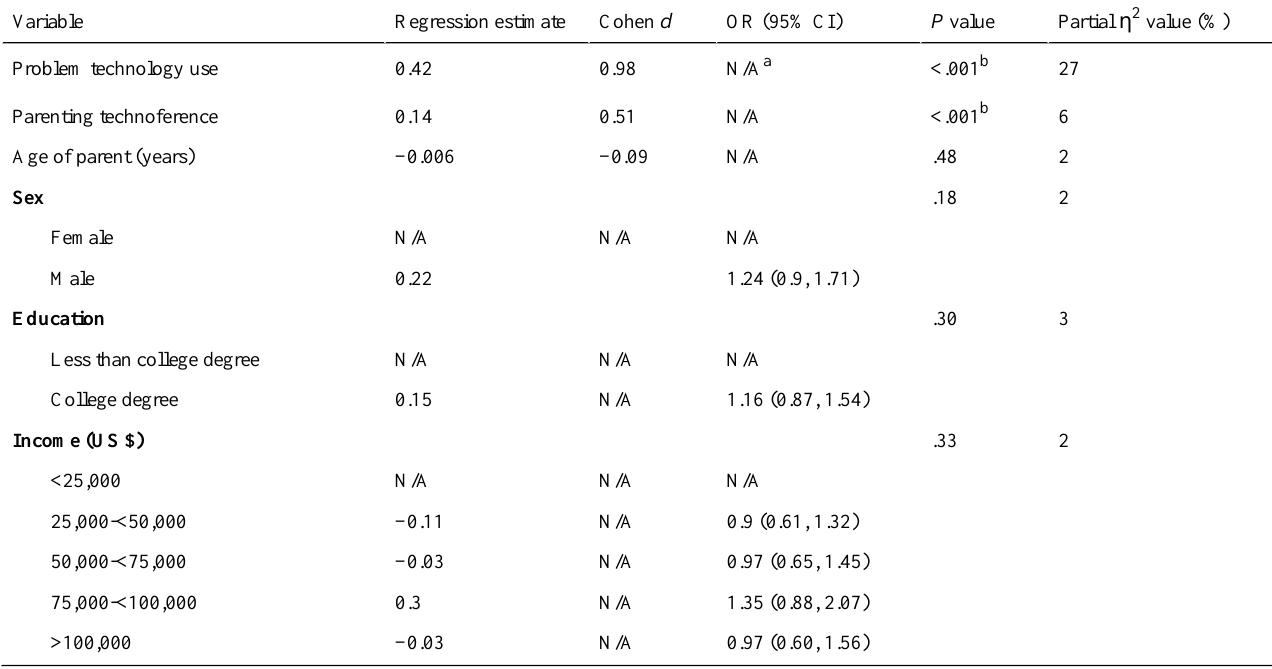
Table 3. Results of the final reduced regression model with technology acceptance as the